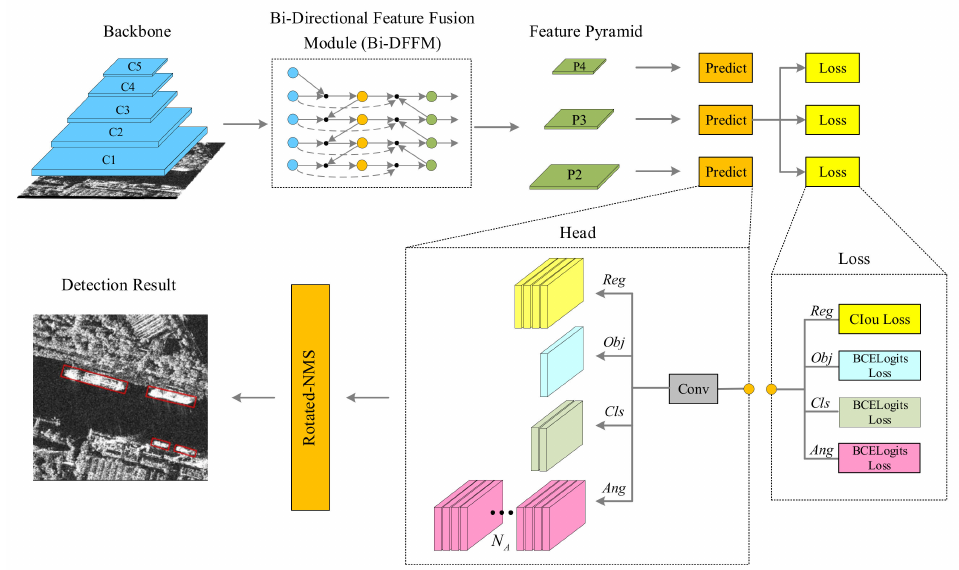
Figure 2. The overall scheme of the proposed